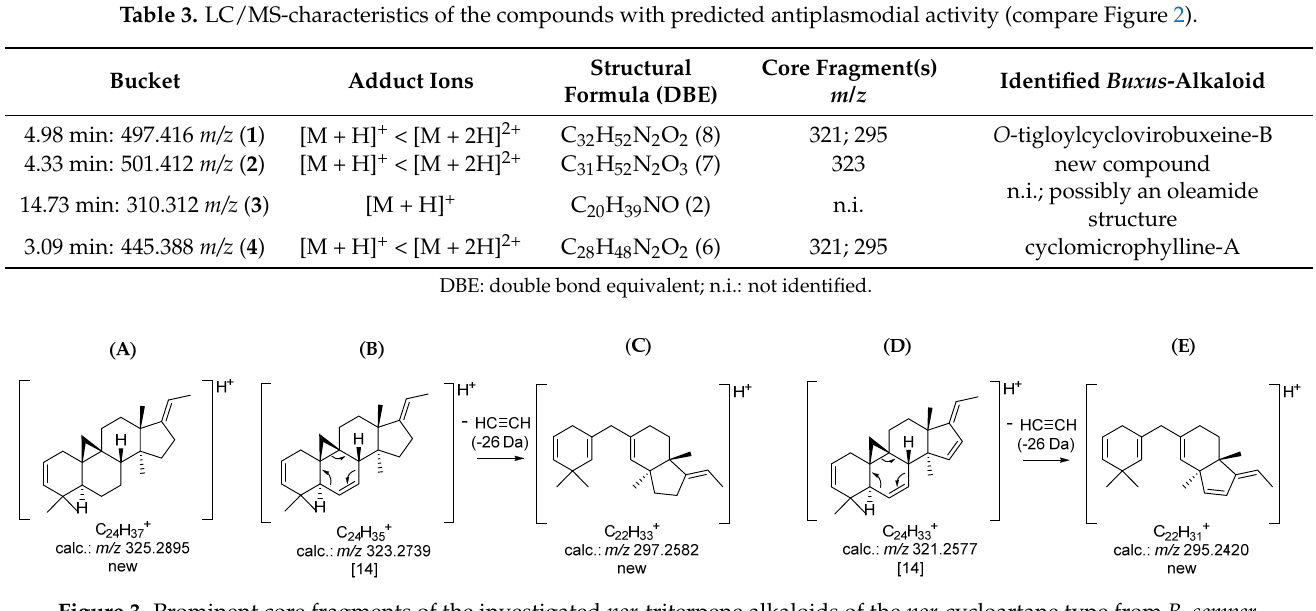
Figure 3. Prominent core fragments of the investigated nor -triterpene alkaloids of the nor -cycloartane type from B . sempervirens L. ( A ) core fragment m/z 325 for fully saturated C-3/C-20 diamines; ( B ) core fragment m/z 323 for C-3/C-20 diamines possessing one additional substitution or double bond; ( C ) core fragment m/z 297 for C-3/C-20 diamines with a ∆ 6 ; ( D ) core fragment m/z 321 for C-3/C-20 diamines doubly substituted or unsaturated; ( E ) core fragment m/z 295 for C-3/C-20 diamines with a Δ 6 and one further substitution or unsaturation. (The postulated positions of unsaturation are based on the already known structures of compounds 1 and 4 ).